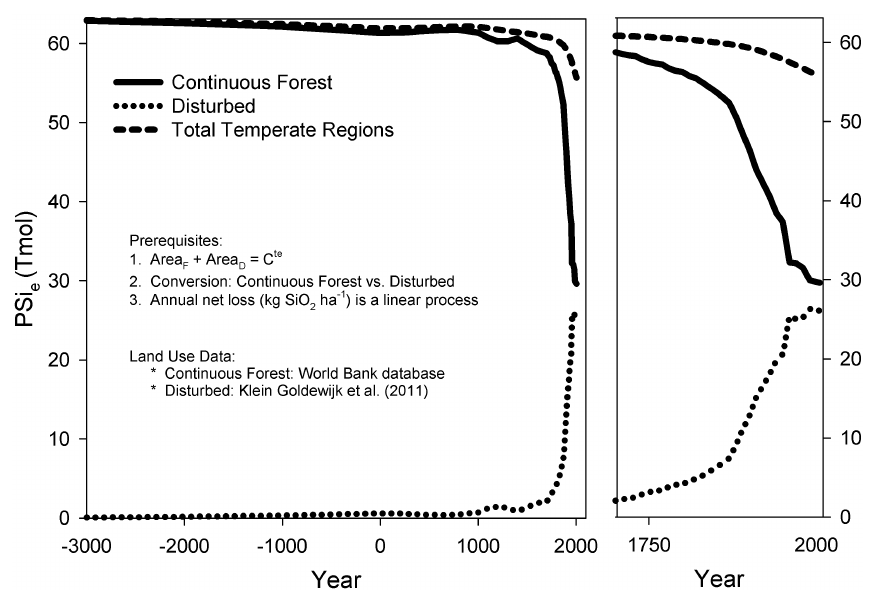
Fig. 6. Historical evolution (3000BCE–2005CE) of the easily soluble silica pool (PSi e , Tmol) for continuous, disturbed and total land area in temperate